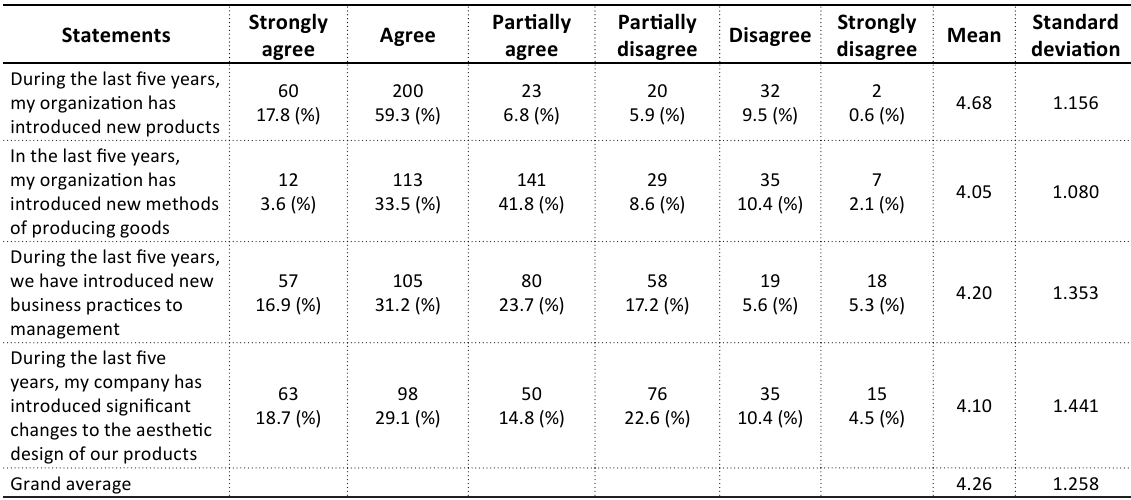
Source: Computed from field reports (2018).